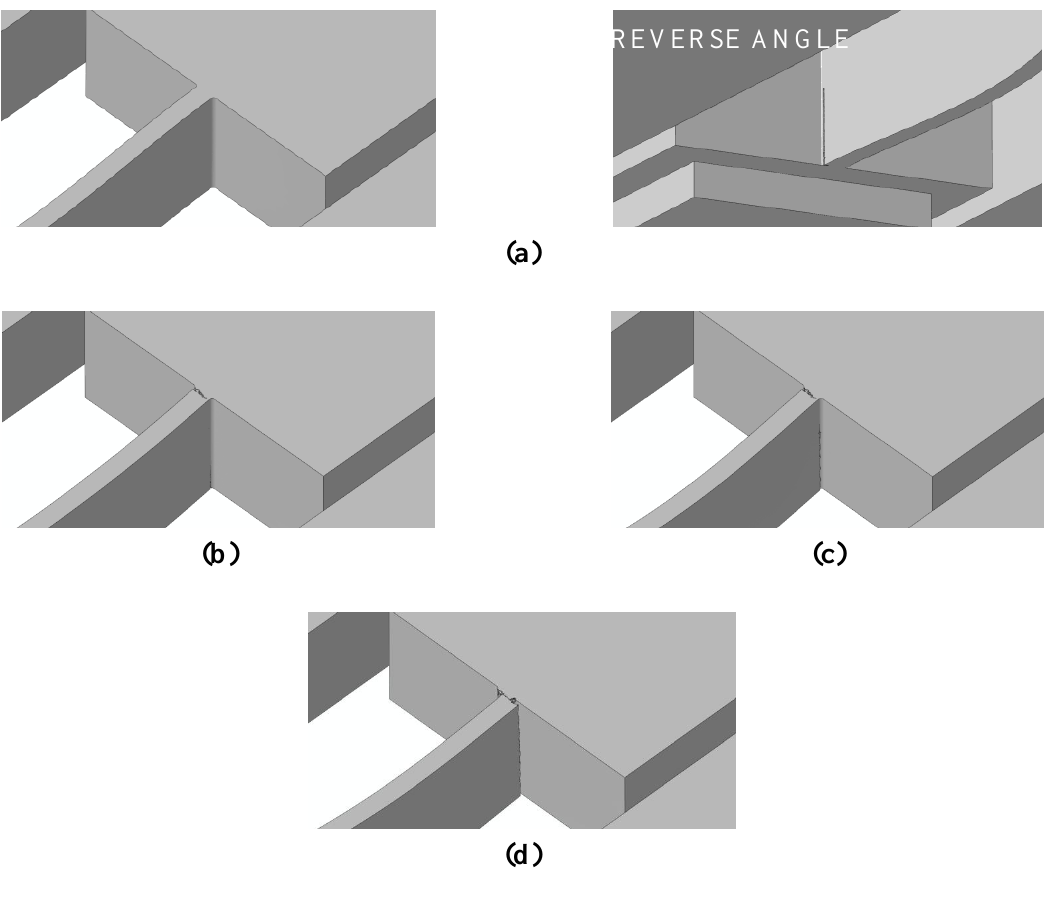
Figure 16. Side-B drop, forecasted crack patterns at time (a) t = 0.77  s, (b) t = 0.78  s, (c) t = 0.79  s, and (d) t = 0.81 